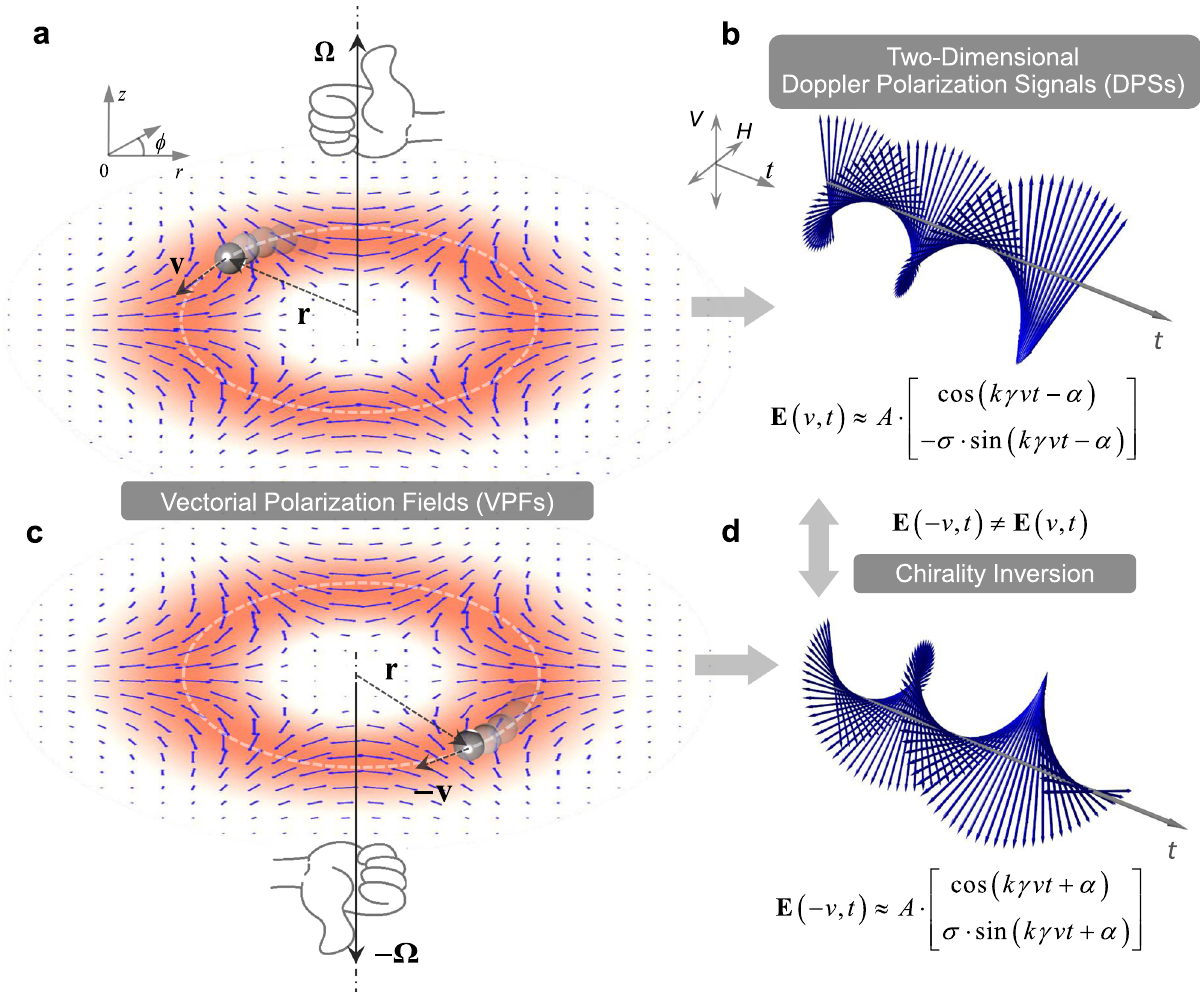
Fig. 1 Vectorial Doppler effect with spatially variant polarized light fi elds used for determination of motion vector. a , c The cylindrical HE 31 -like fi eld as a representative vectorial polarization fi eld (VPF) is conceptually shown for direct detection of a moving particle with opposite rotational velocity vectors, respectively. b , d Two-dimensional Doppler polarization signals (DPSs) scattered from the VPFs show chirality inversion for opposite rotational velocity vectors. The two-dimensional DPSs carry full information (magnitude and direction) of velocity vectors, which is not accessible by classical Doppler effects based on a single scalar optical fi eld. The blue arrows denote state of polarization (SoP). r radial vector, v linear velocity, Ω angular